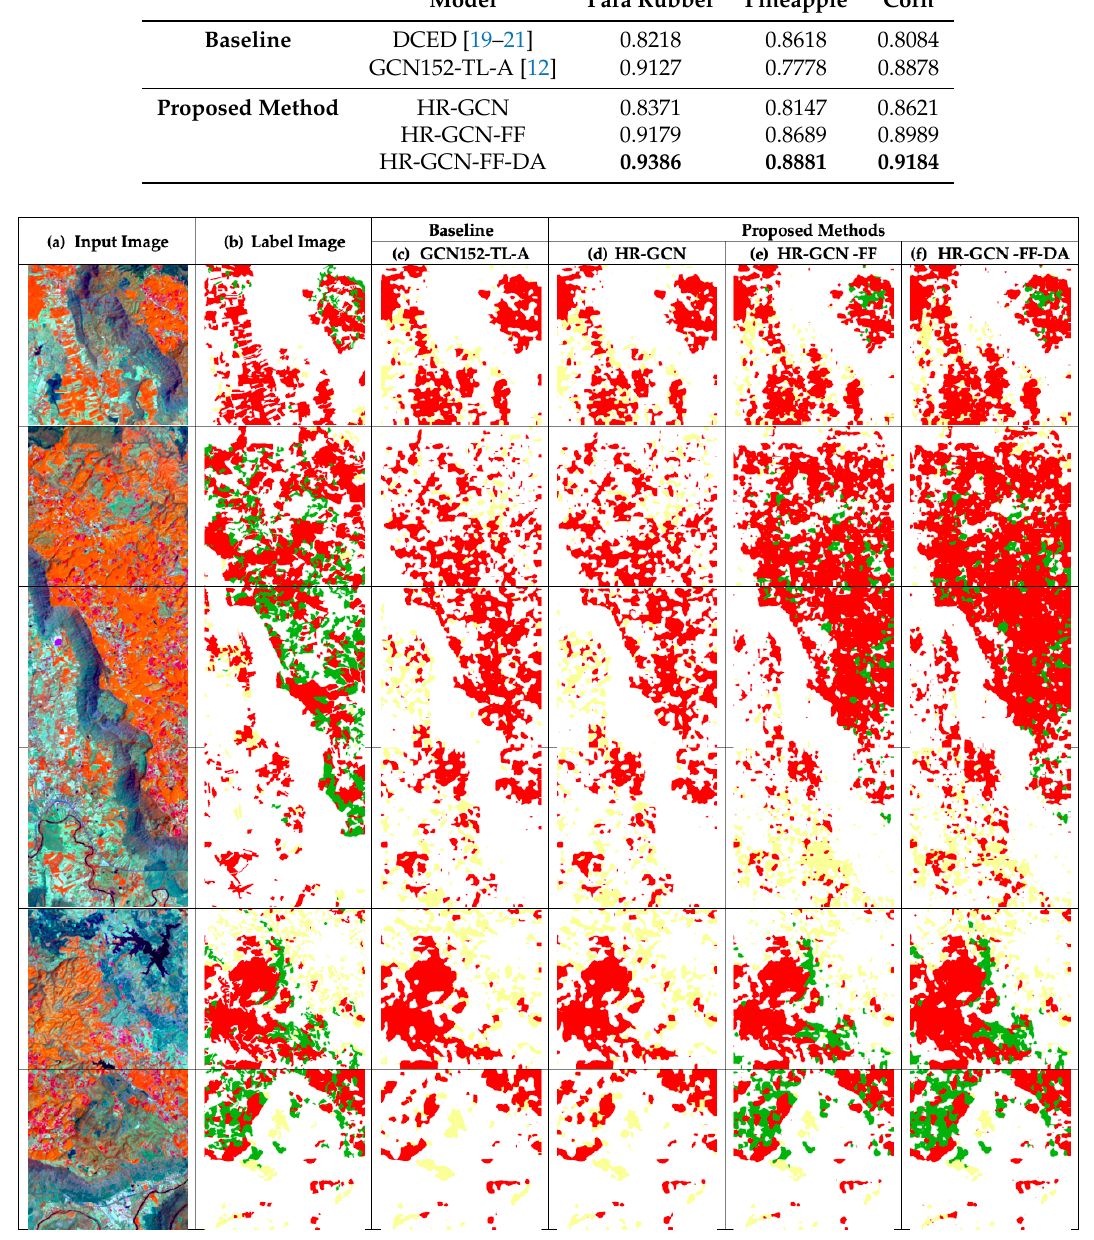
Figure 10. Comparisons between “HR-GCN-FF-DA” and other published methods of the Landsat-8w3c corpus testing